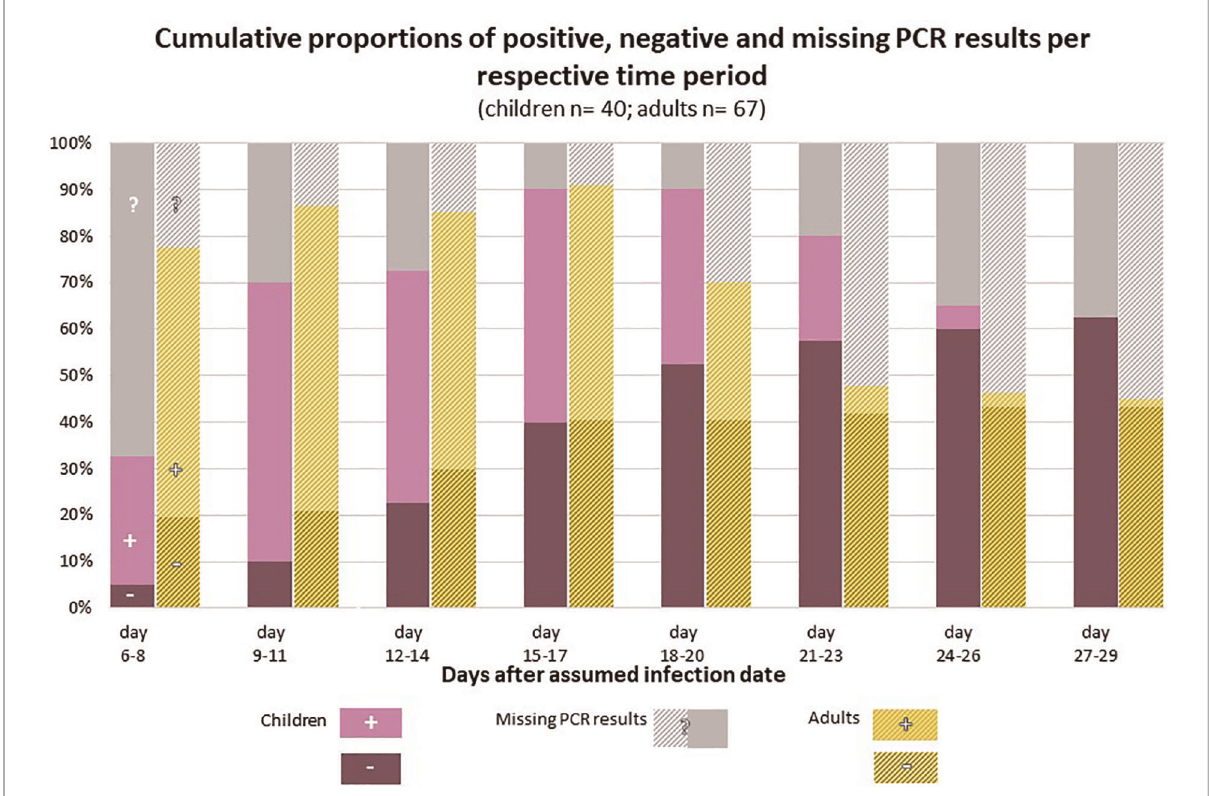
FIGURE 2 Cumulative proportion of children and adults with a negative (purple) PCR test on SARS-CoV-2, compared to the proportion of children and adults who were still tested positive (pink) at different points of time after the assumed infection. PCR test results were not available from all study participants at all points of time; the proportion of children and adults for whom no information of a SARS-CoV-2 PCR was available at a given point of time is shown in grey color. Reasons for missing PCR tests were for example that participants were not yet included in the study, e.g. index cases had probably been infected more than 6 – 8 days ago when the study team arrived for the testings (enrolment started 4 – 6 days after test date of index case). Other cases fi nished their 12-day self-sampling period earlier than day 20, or 24, or 27 after their infection date. In addition, few participants skipped single sampling